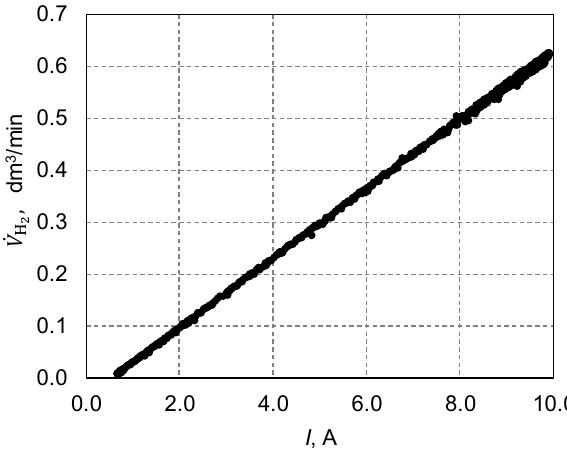
Figure 9. The hydrogen flow rate as a function of the H 2 generator supply current.